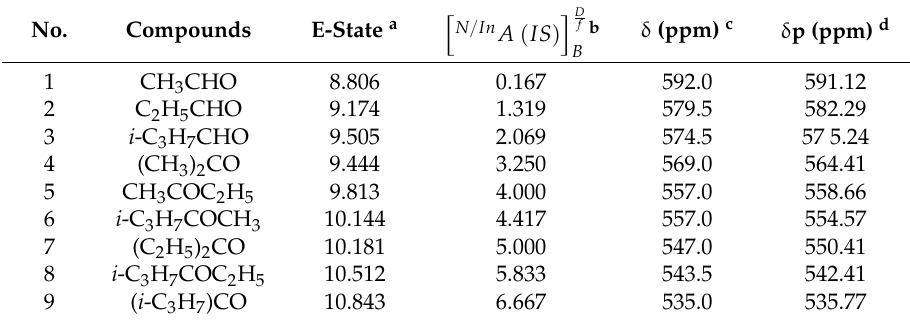
Table 10. Chemical Shift p δ q in 17 O-NMR and GDI